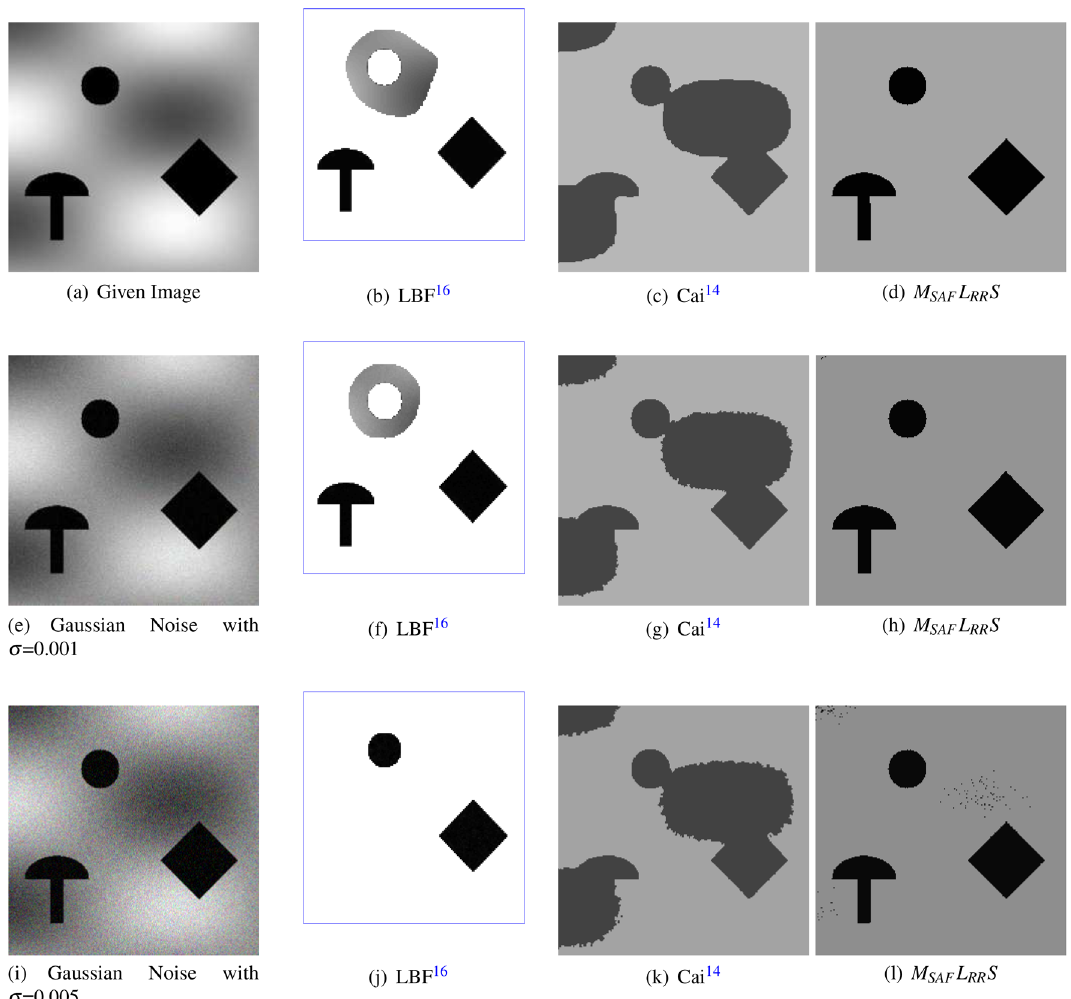
Figure 9. Segmenting a synthetic image, using the LBF approach, Cai et al. 14 method, and the suggested M SAF L RR S approach. The first column represents the original image and its noisy version, while the second column characterizes the result of the LBF method. Furthermore, the third and forth columns represent the segmented outcomes of the Cai et al. 14 and proposed model, respectively. Furthermore, the parameters used for M SAF L RR S model are (d) (cid:31) 2 = 100 , k = 10 and for (h) and (l) are (cid:31) 2 = 200 , k = 20 . The images were taken from Ref. 33 and are publicly